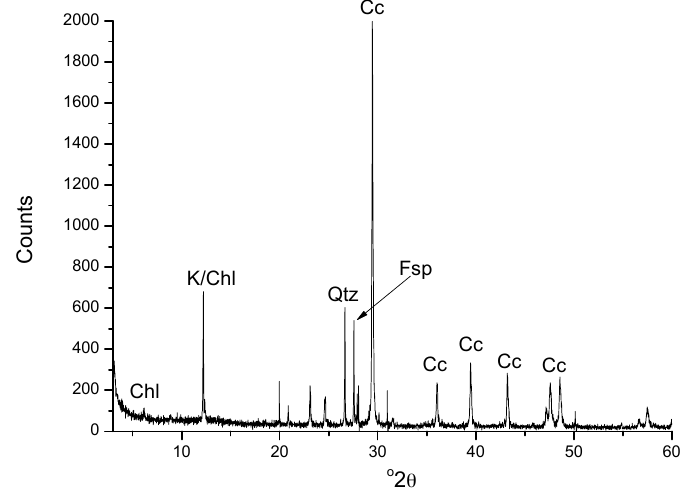
Figure 10. XRD pattern of Sample of area 4 (Chl: chlorite, K, Kaolinite Qtz: quartz, Fsp: feldspars, Cc: calcite).